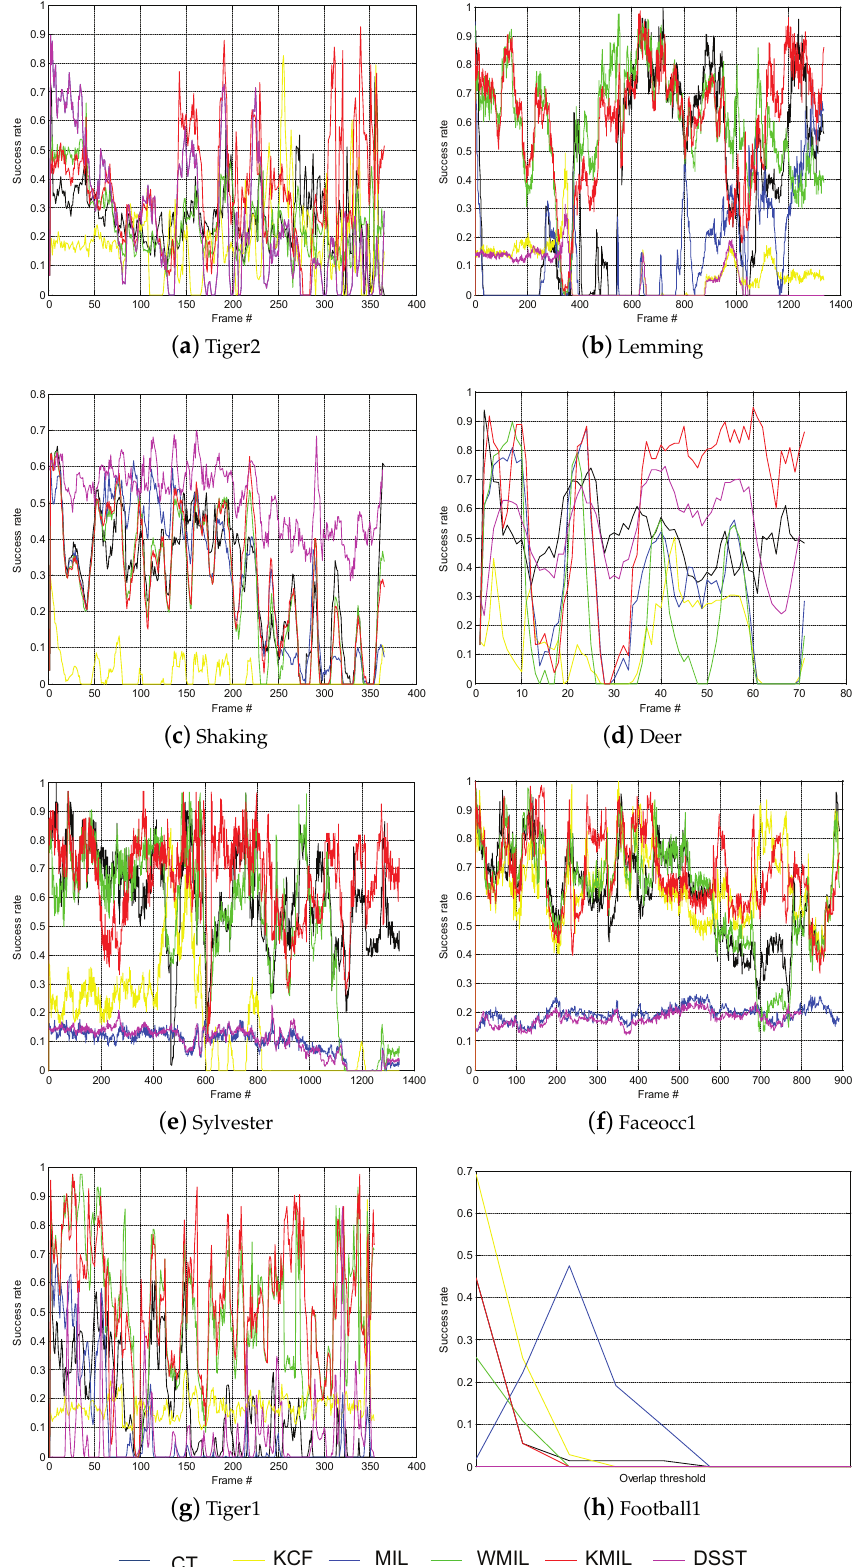
Figure 4. Success plot for sequences: “Deer”, “Tiger2”, “Faceocc2”, “Sylvester”, “Football1”, “Shaking”, “Tiger1”,